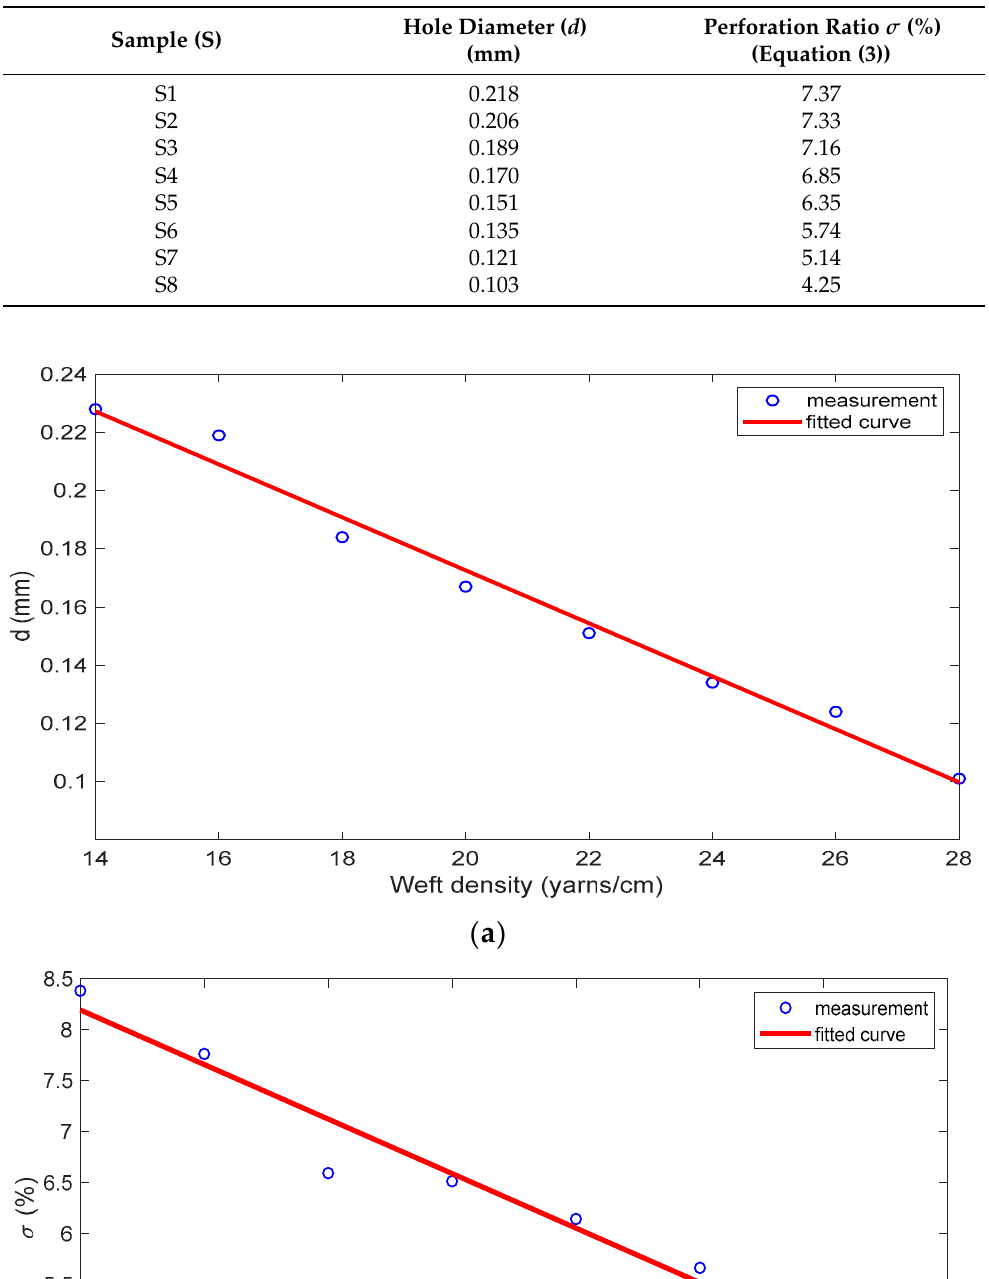
Table 2 . Hole diameter and perforation ratio woven fabrics .